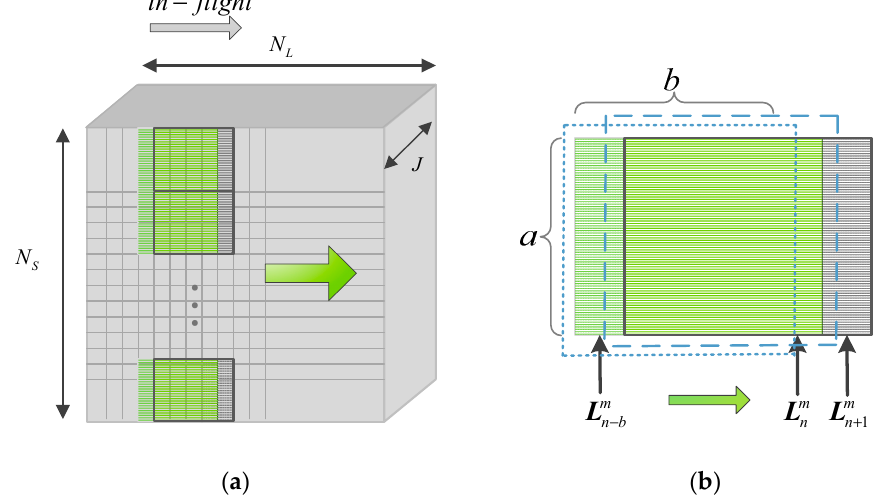
m L and L . n 1 n + n + 1